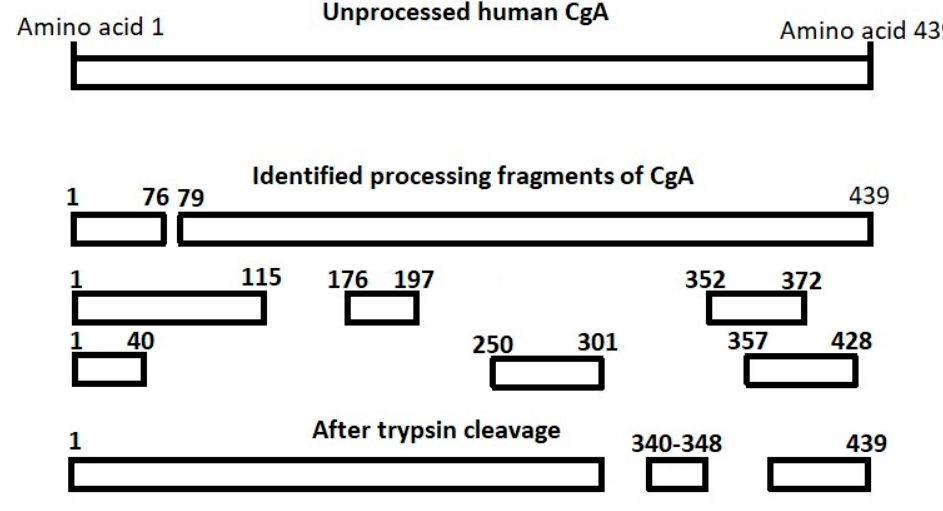
Figure 1. Identified processing products of chromogranin A (CgA). The fragments have been suggested to be bioactive with different primarily inhibitory effects. The CgA 340-348 sequence does not undergo post-translational processing. CgA 340-348 is located between tryptic cleavage sites and one CgA 340-348 fragment will be released per CgA molecule when a sample is pre-incubated with trypsin, thus providing an accurate measure of the total CgA concentration of the sample.